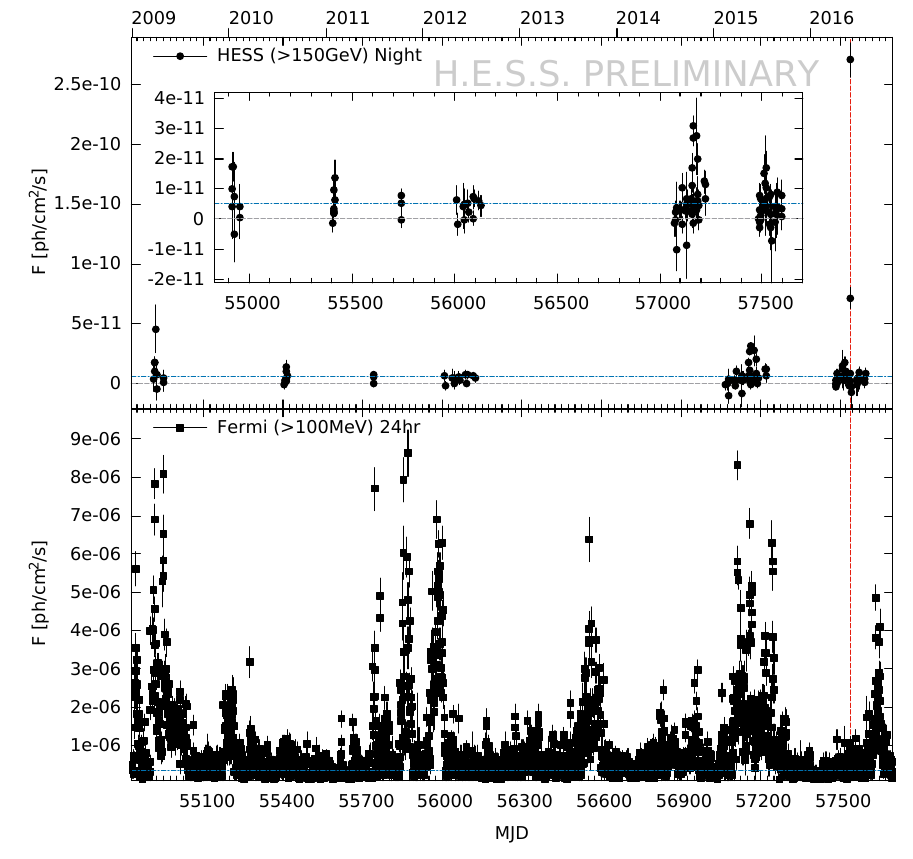
Figure 1. Nightwise binned fluxes from 2009 to 2016 in the VHE band taken with H.E.S.S. (top panel) and the HE band taken with Fermi -LAT (bottom panel). The inset shows a zoom in on VHE fluxes without the 2016 flare. The blue dash-dotted line marks the average flux, while the gray dashed line marks the zero-flux level. The vertical red dashed line marks the time of the VHE flare in